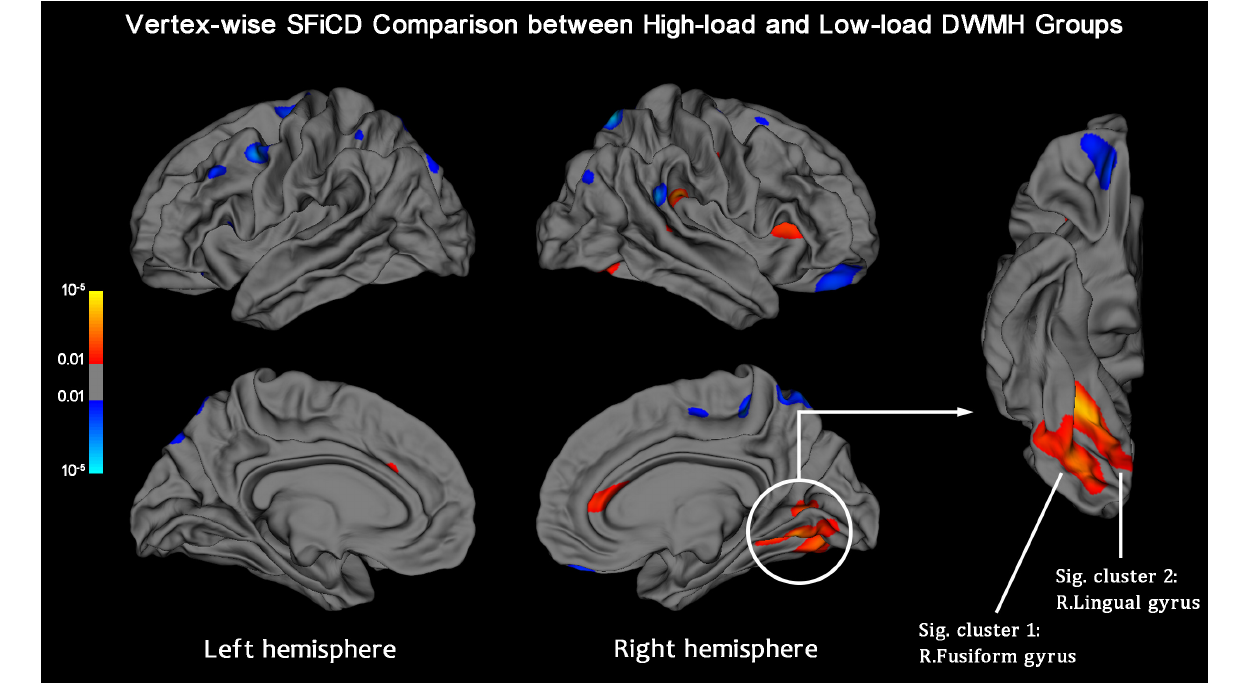
FIGURE 2 | Vertexwise SFiCD comparison between the low-load and high-load DWMH groups. The statistical map is thresholded with a vertex-level P < 0.01. The cluster that survived Monte Carlo simulation correction (cluster-level P < 0.01) is further marked with a circle. Compared with the low-load DWMH group, the high-load DWMH group showed a significantly increased SFiCD in the right fusiform gyrus (Sig. cluster 1) and right lingual gyrus (Sig. cluster 2).